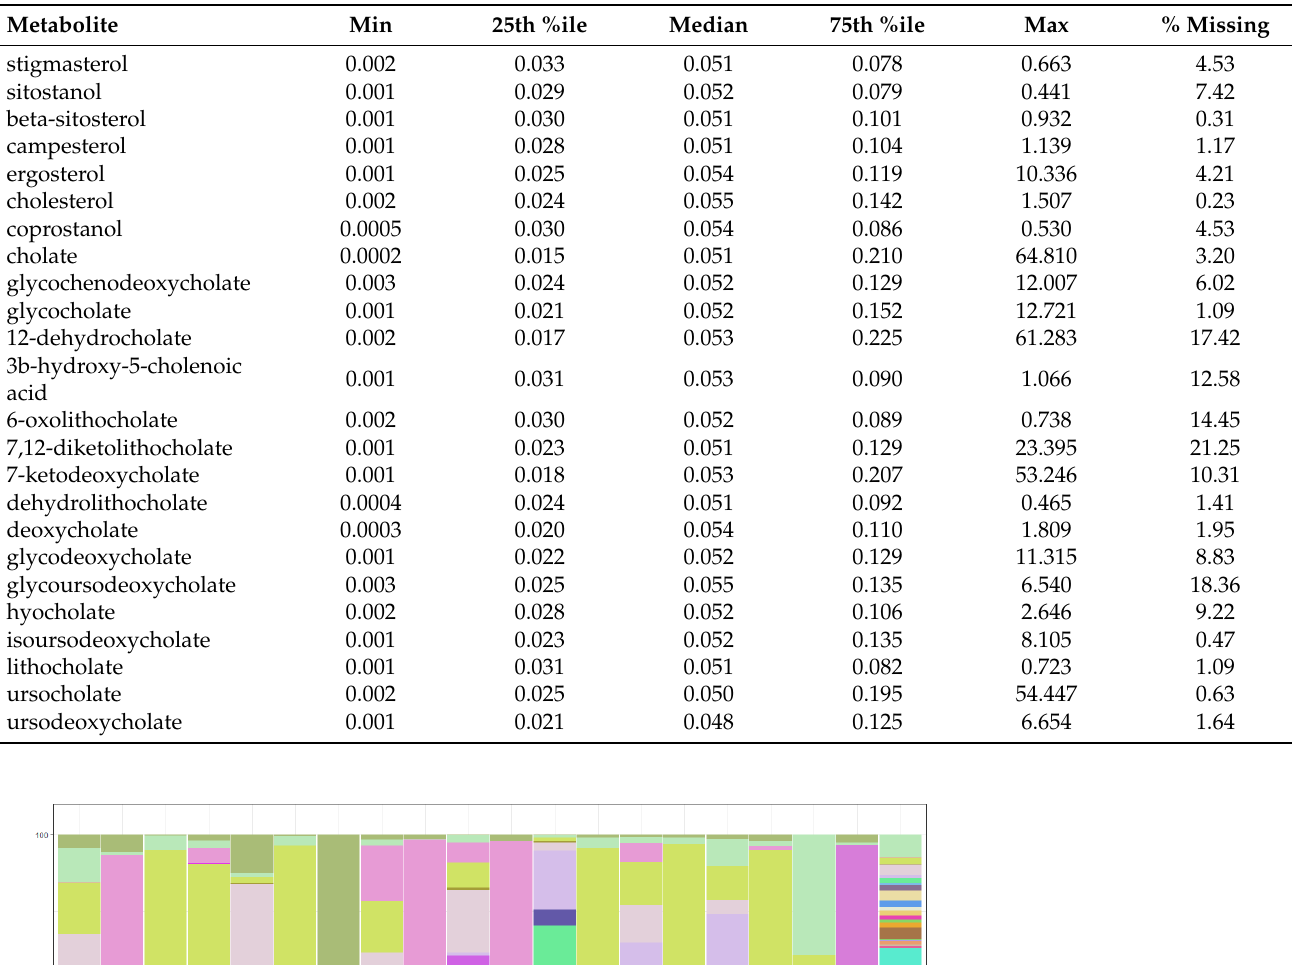
Table 2. Metabolite Summary Statistics.